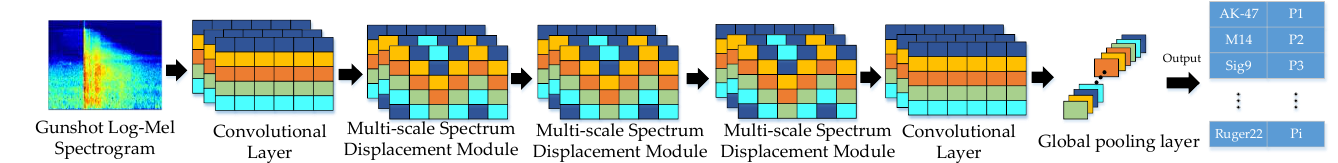
Figure 3. Multi-scale spectrum shift dense neural network.